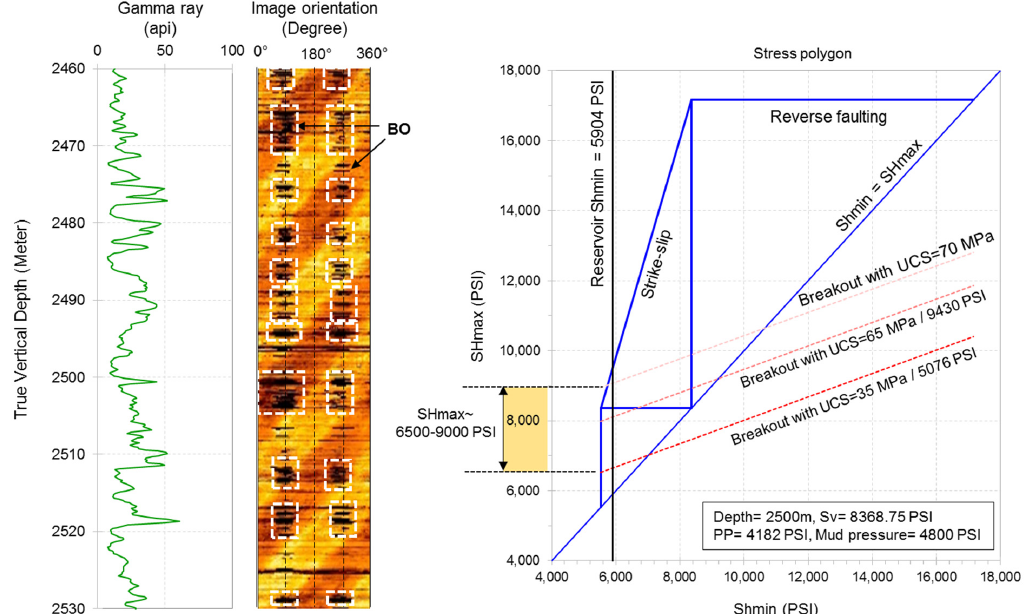
Figure 8. Inferred SHmax azimuth (N170 ◦ E) from breakouts (BO) observed in the ultrasonic image log of Well-5 (interpreted BO zones are marked by white boxes); stress polygon approach to constrain SHmax magnitude indicating normal fault to strike-slip tectonic stress state in the Turonian carbonate